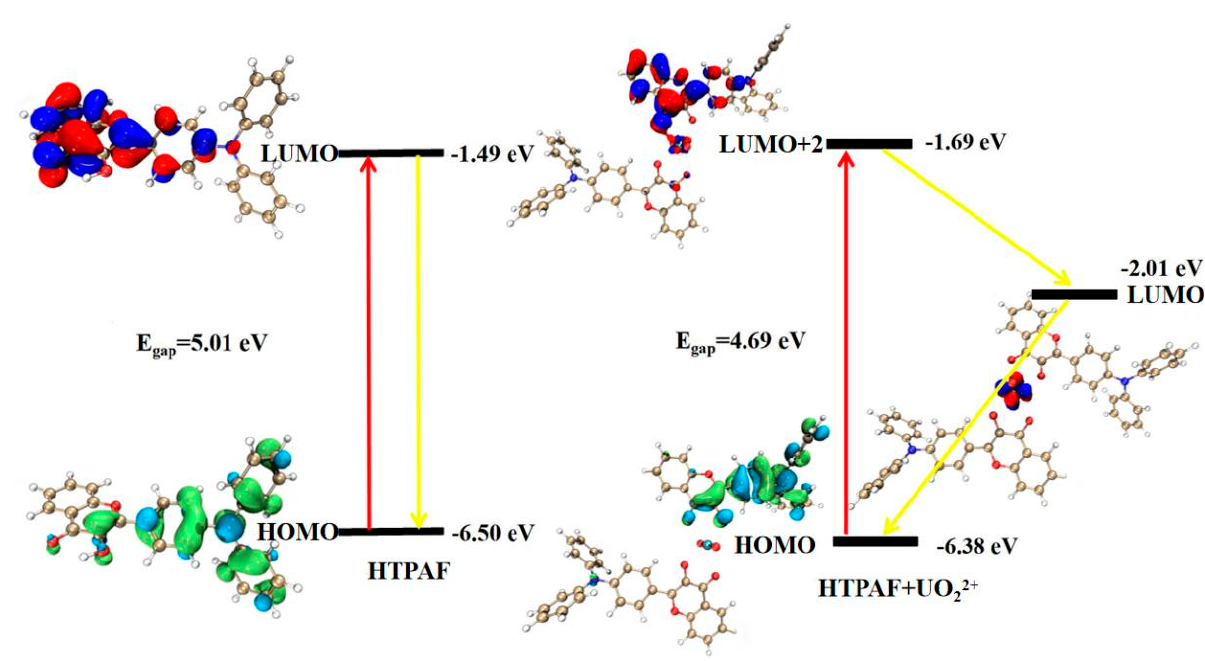
Figure 14. Schematic diagram and mechanism diagram of HTPAF fluorescent probe and fluorescent probe HTPAF forming complex with UO 22+ .